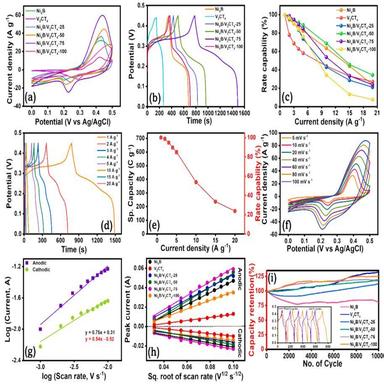
(a) CV curves for all electrodes plotted at a scan rate of 20 mV s − 1 (b) GCD curves for all electrodes recorded at a current density of 1 A g− 1 (c) current density vs. rate capability (d) GCD curves for the NixB/V2CTx-75 electrode recorded at different current densities (1–20 A g− 1 ), (e) current density vs. specific capacity and current density vs. rate capability for the NixB/V2CTx-75/NF. (f) CV curves for the NixB/V2CTx-75 electrode at different scan rates (5–100 mV s − 1 ), (g) Corresponding linear